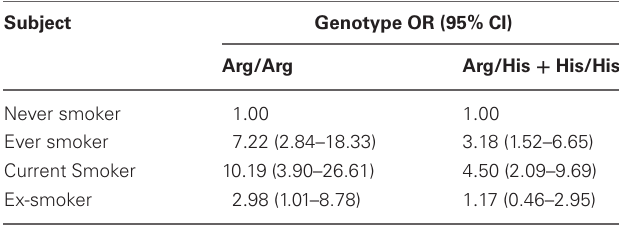
Table 2 | Association between smoking and oral cancer according to Arg 213 His SULT1A1 polymorphism, oral cancer cases and controls, Rio de Janeiro, Brazil,